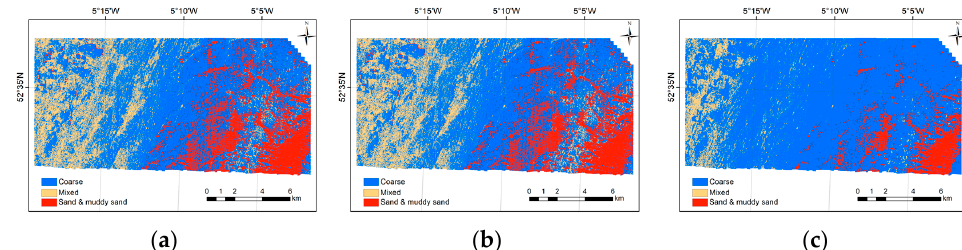
Figure 14. Three decision fusion results based on different traditional classifiers in S2. ( a ) RPNet-RF; ( b ) RPNet-KNN; ( c ) RPNet-SVM.